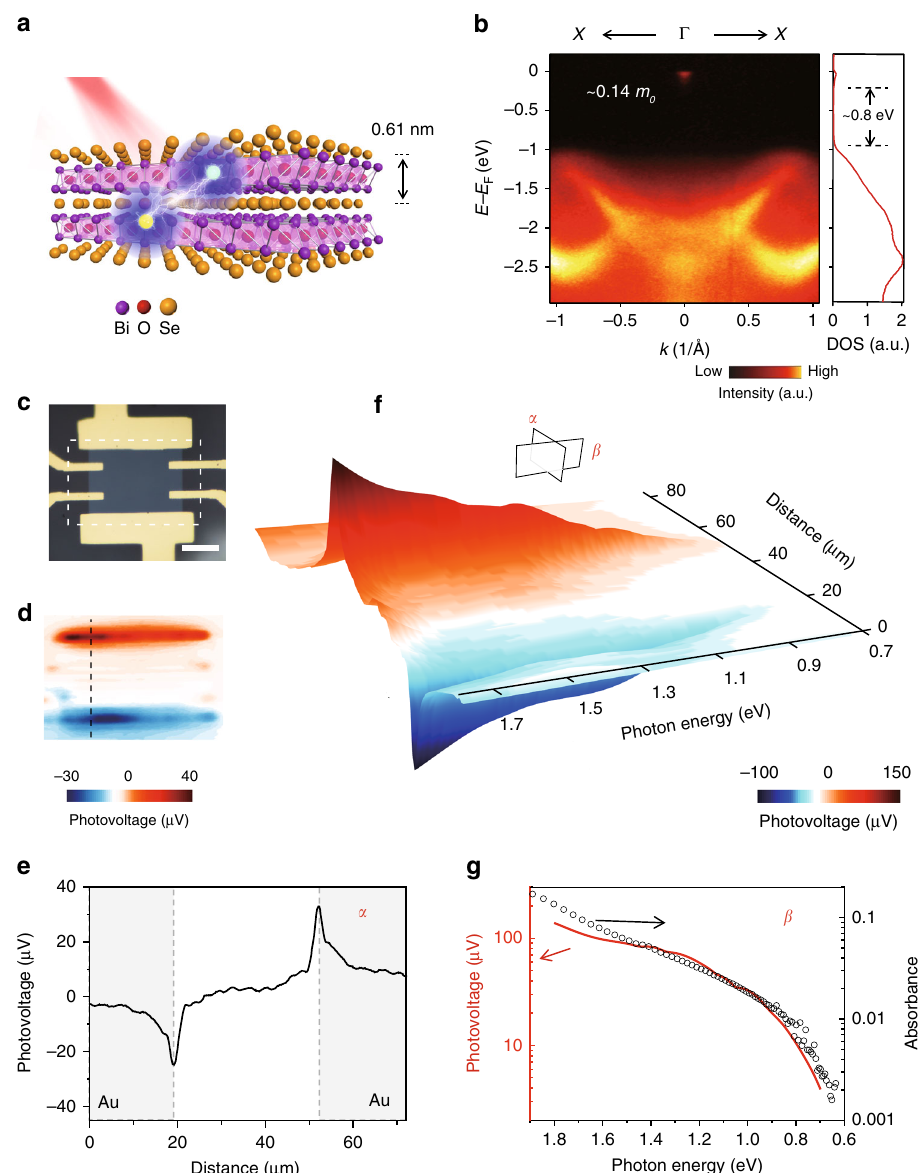
Fig. 1 Photodetectors based on 2D Bi 2 O 2 Se. a Illustration of photodetector based on 2D Bi 2 O 2 Se crystal, with schematic crystal structure of alternatively stacked (Bi 2 O 2 ) n and Se n layers. The layer thickness is 0.61 nm. b Electronic structure of Bi 2 O 2 Se observed by ARPES, which shows an indirect band gap of ~0.8 eV and small effective mass of ~0.14 m 0 . The spectra under E – E F = − 1 eV and around E – E F = 0eV correspond to valence and conduction band, respectively. E F refers to Fermi level, so only tiny conduction band structure under Femi level is observed here. The directions of ARPES mapping are along X – Γ – X directions. The right panel is the corresponding density of states (DOS), which is calculated by integrating signals of the left panel along momentum space. c Optical image of Bi 2 O 2 Se device with thickness of ~10 nm and ~16 layers, scale bar 20 μ m. d Scanning photovoltage image of the dotted rectangle area of device in c . The 1200 nm laser with power of 150 μ W is focused and scanned on the device, while the net photovoltages are recorded as function of laser positions. The photovoltages are measured without external bias. e Line-scanning of photovoltage along dotted line in d . The curve corresponds to the α -plane cut of f . The two peaks correspond with Bi 2 O 2 Se-metal junctions. f Spectrogram composed of photovoltage line scans at different incident photon energies (wavelength of incident light). The incident photon numbers are kept still during the measurement, and the incident power is 100 μ W at 1200 nm. g Photovoltage and absorbance of Bi 2 O 2 Se as function of incident photon energy. Red solid line shows photovoltage trace, which corresponds to β -plane cut of the spectrogram. Black circles show the absorbance of Bi 2 O 2 Se fi lm with ~10 nm in